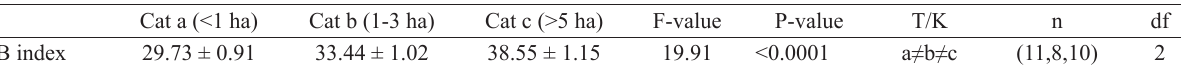
Table 4. ANOVA and Tukey/Kramer results for the analysis of degraded forest biological index values (B index, mean ± SE) with forest patch size (S, mean ± SE). Patch size categories are similar to those in Table 3. (df, degrees of freedom; T/K,